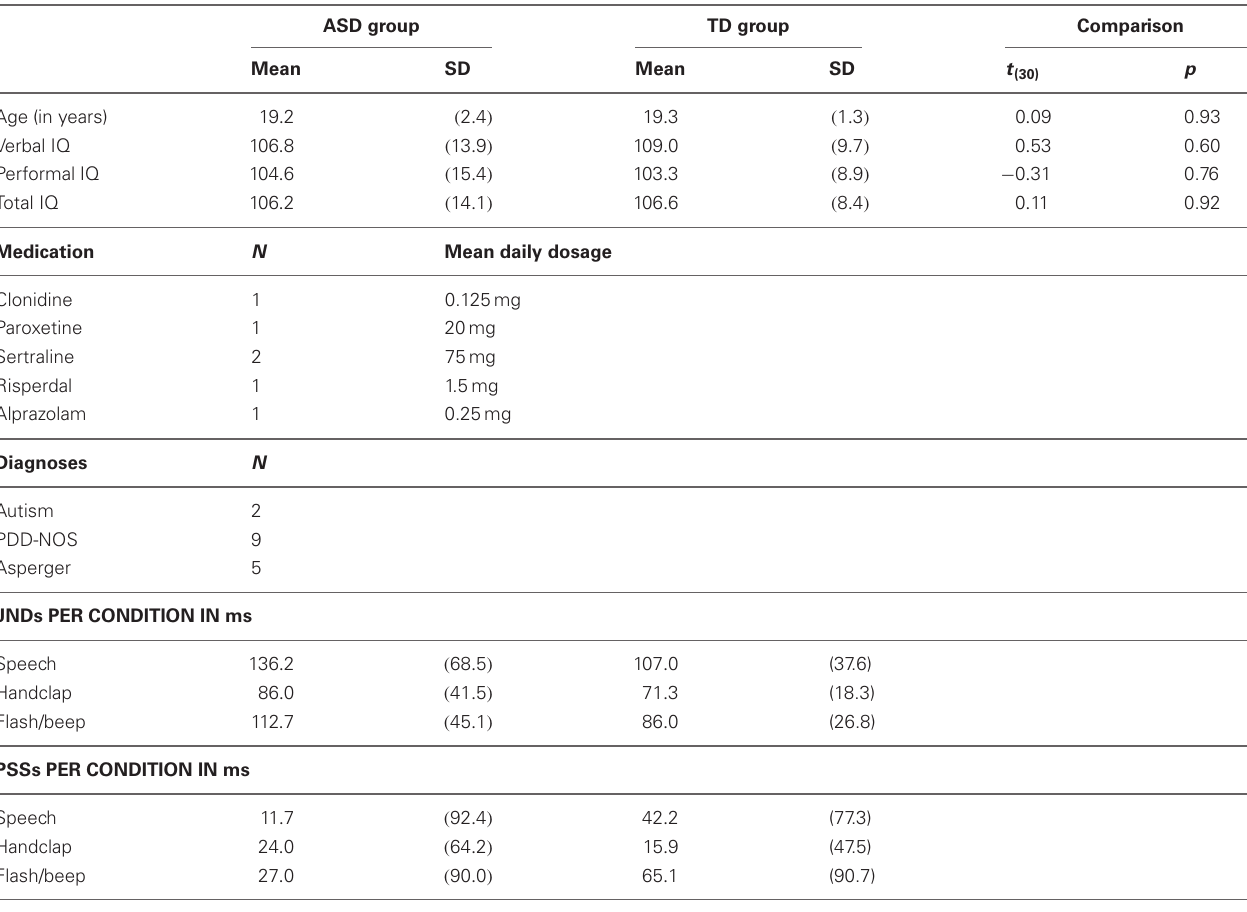
Table 2 | Overall demographics and comparison per group and mean Just Noticeable Difference (JND) and Point of Subjective Simultaneity (PSS) in ms and Standard deviations per